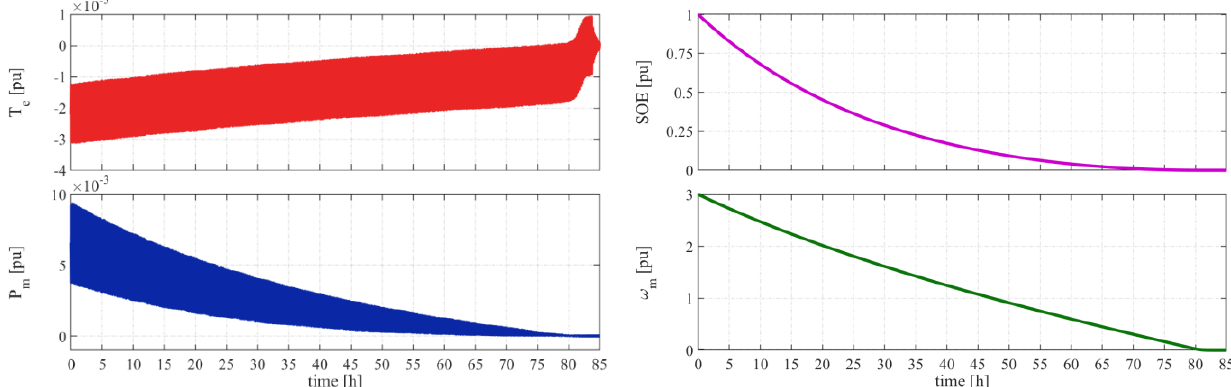
Figure 11. The dq components of M/G-side and grid-side current space vectors ( i m,dq and i g,dq , respectively) achieved during round-trip tests (cases A1 and A2, quantities normalized to their corresponding rated values).